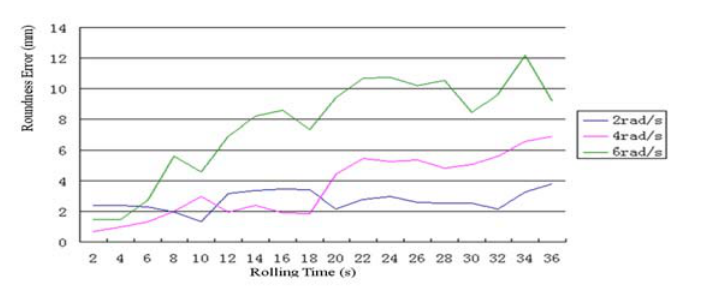
Fig. 9. The relation curves between the speed of the drive roller and the roundness error